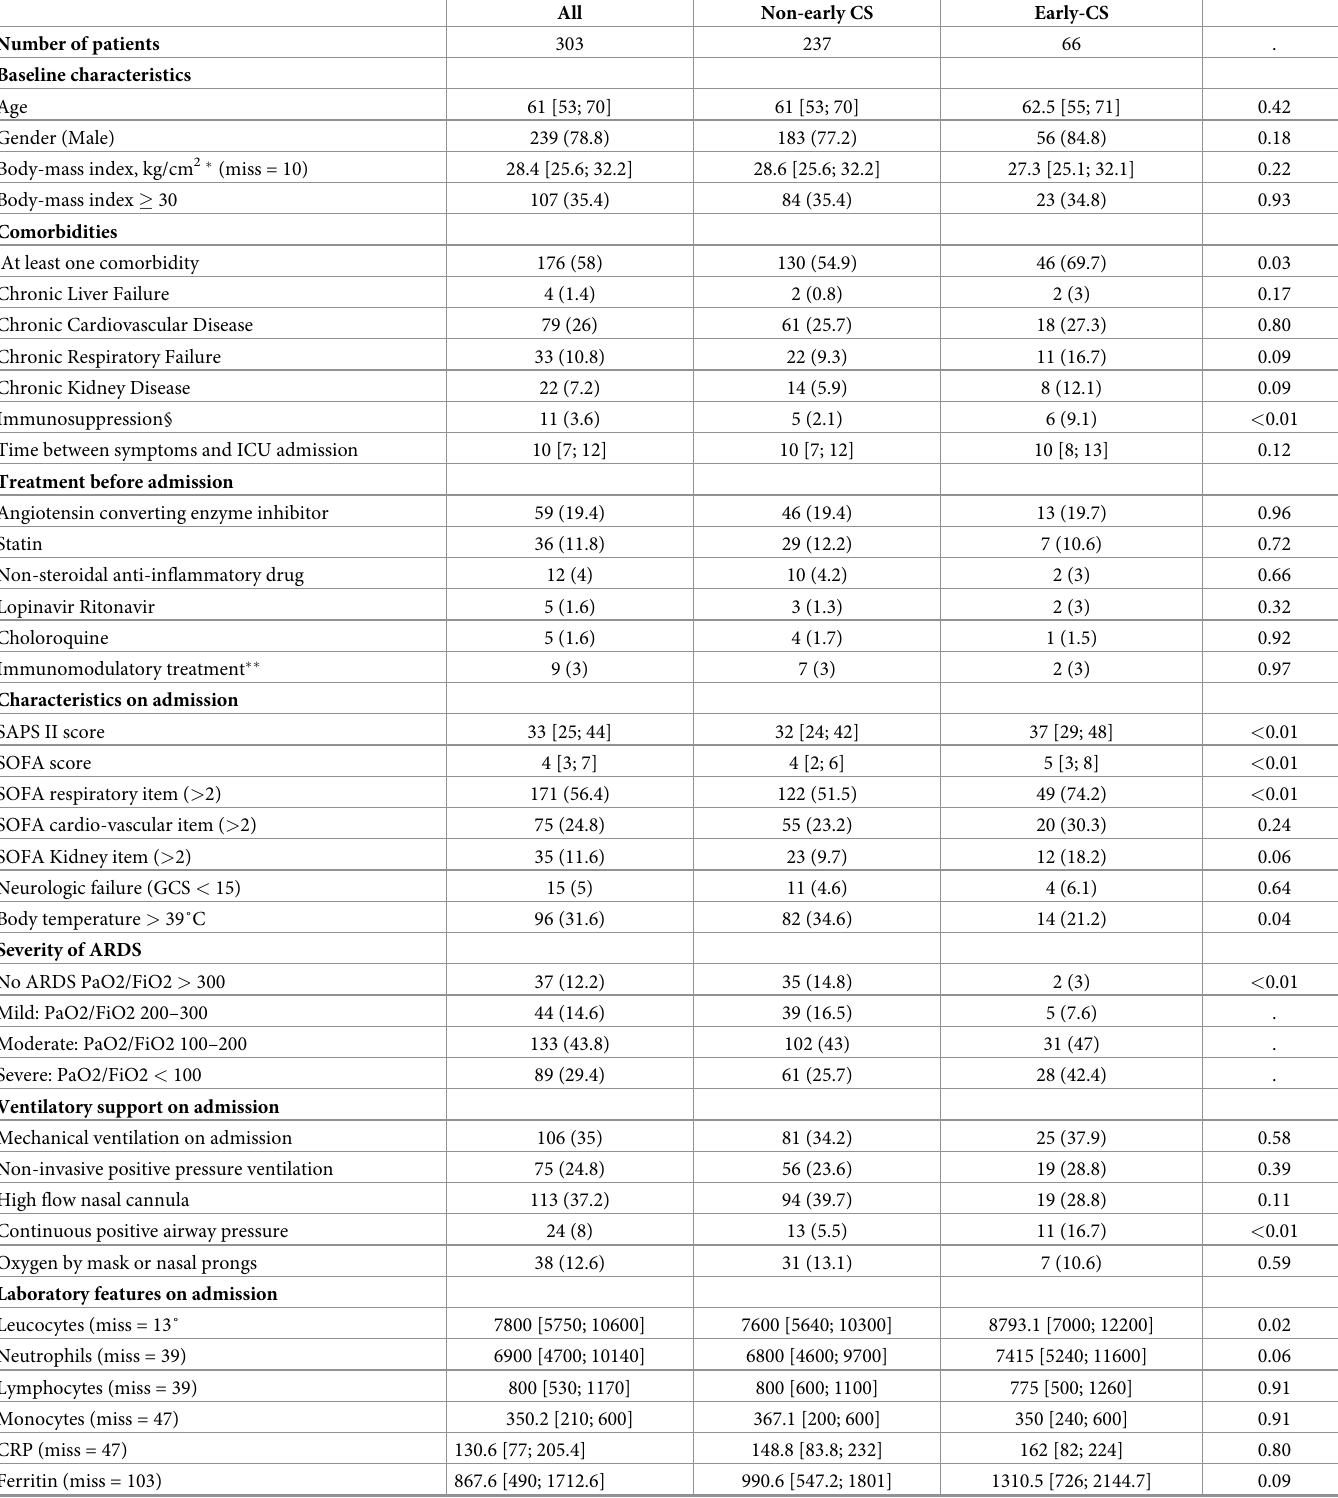
Table 1. Comparison of the baseline characteristics of patients with and without early corticosteroids after ICU admission.